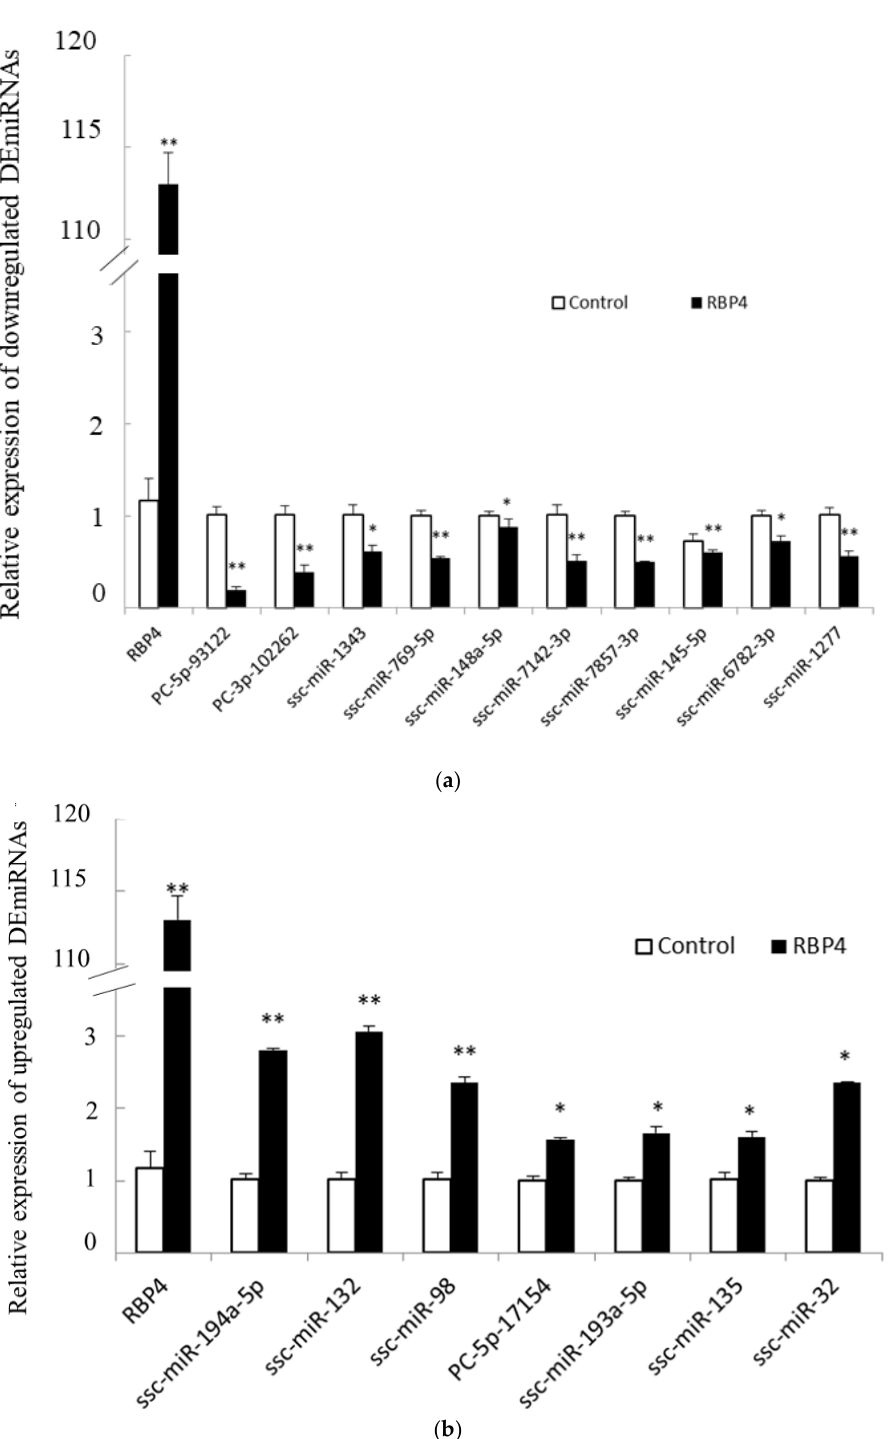
Figure 3. RT-qPCR validation of DEmiRNAs. ( a ) Relative expression of 10 downregulated DEmiRNAs. ( b ) Relative expression of 7 upregulated DEmiRNAs. The data are expressed as the mean ± SEM (* p < 0.05, ** p < 0.01).